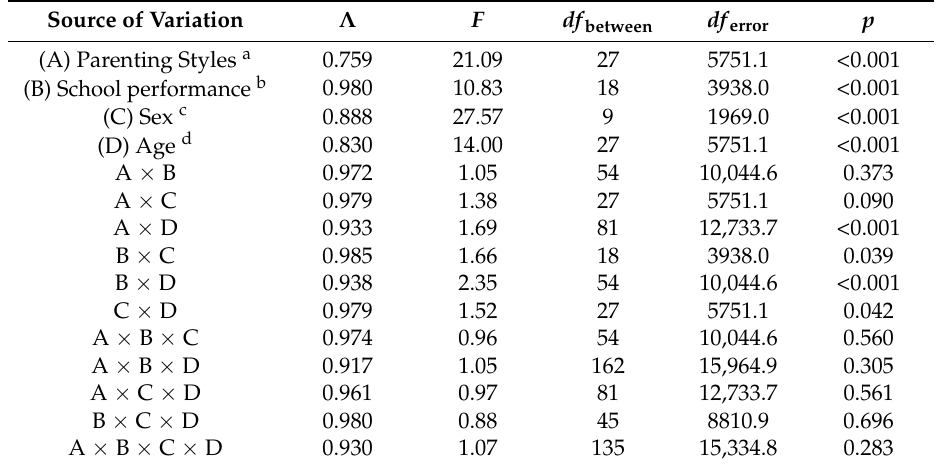
Table 2. Four-way multivariate analysis of variance (MANOVA) factorial 4 × 3 × 2 × 4 for the three sets of outcomes measures: self-esteem, psychosocial maturity, and emotional maladjustment.